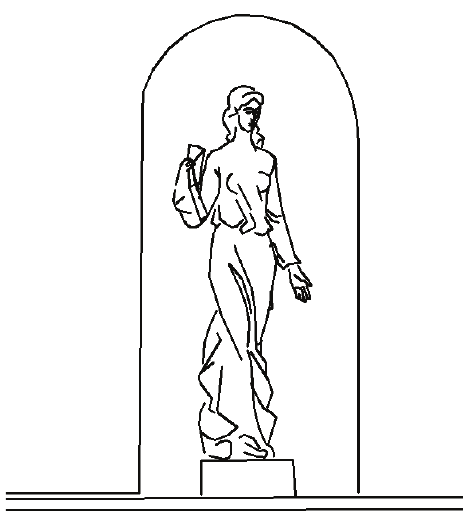
Fig. 3. Break lines of an object